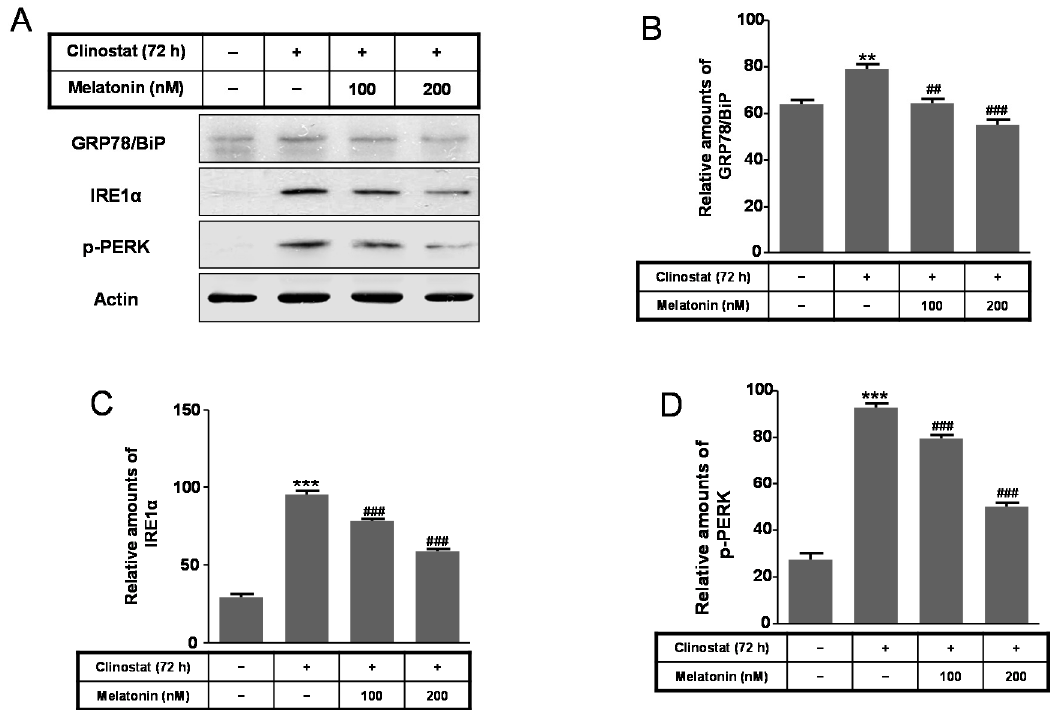
Figure 5. Expression of GRP78/BiP, IRE1 α , and p-PERK with clinostat rotation and/or melatonin treatment in MC3T3-E1 cells. MC3T3-E1 cells were cultured in α -MEM added with 10% FBS at 37 °C with 5% CO 2 . To experimentally simulate microgravity with the 3D clinostat, cells were cultured in T-25 cell culture flasks completely filled with a 1:1 mixture of α -MEM and Leibovitz’s L-15 supplemented with 10% FBS and 1% PS, with or without melatonin (100, 200 nM). Phosphorylation of GRP78/BiP, IRE1 α , and p-PERK was then performed by Western blot analysis ( A ); The relative expressions of GRP78/BiP ( B ); IRE1 α ( C ); and p-PERK ( D ) were carried out as described in the Materials and Methods